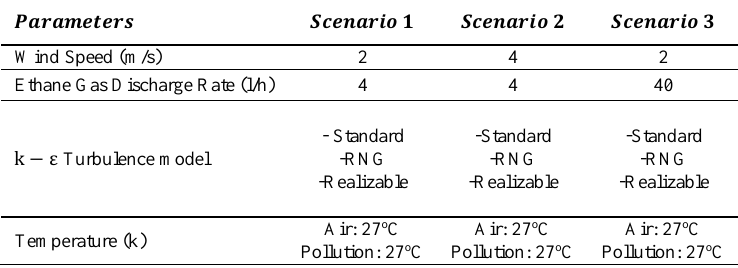
Simulation scenarios using ANSYS Fluent